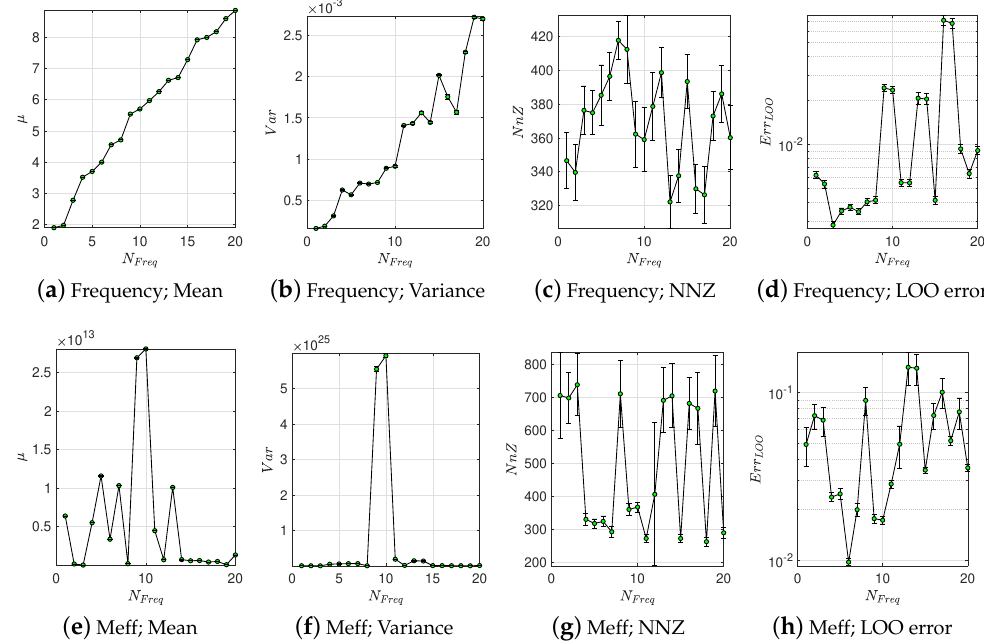
Figure 10. Dam-2; Probabilistic PCE-based surrogate models for different vibration frequencies and QoIs all with 2000